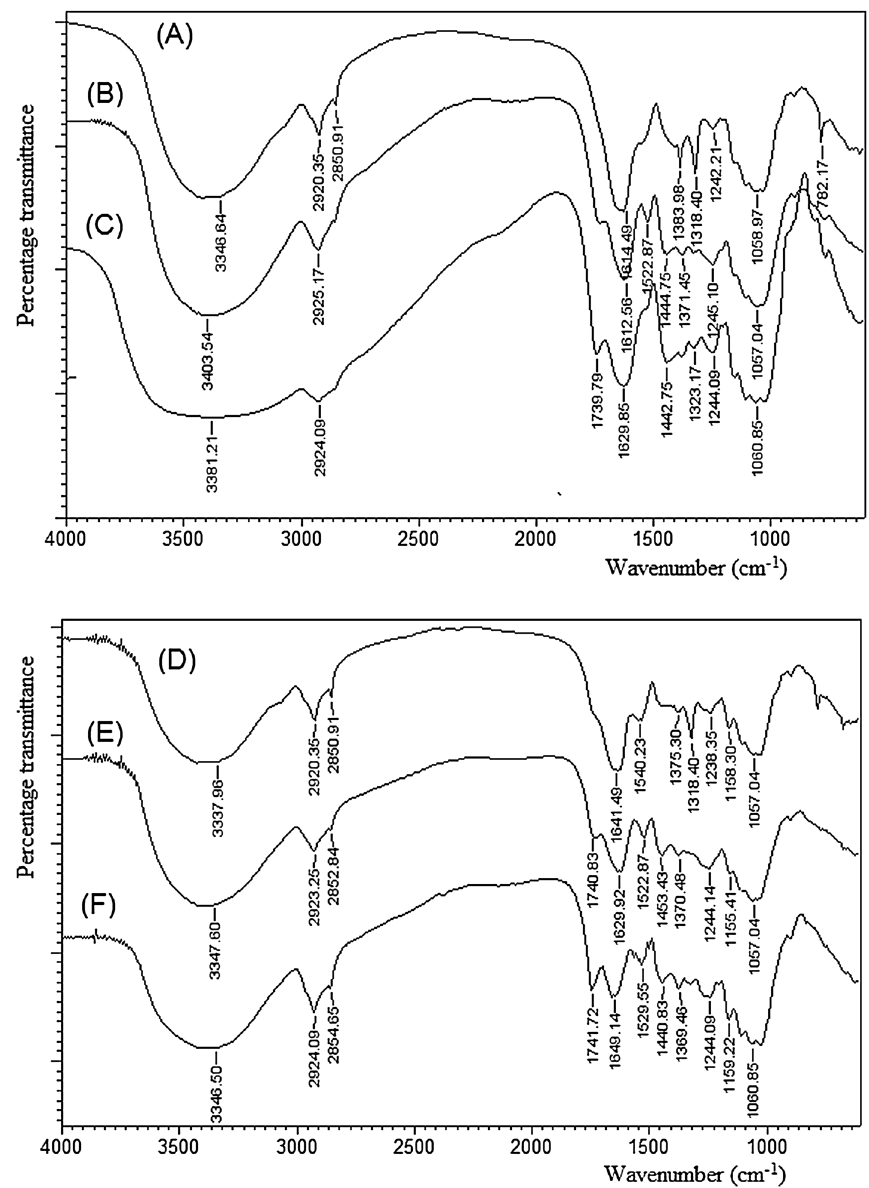
Fig. 1 FTIR spectra of a